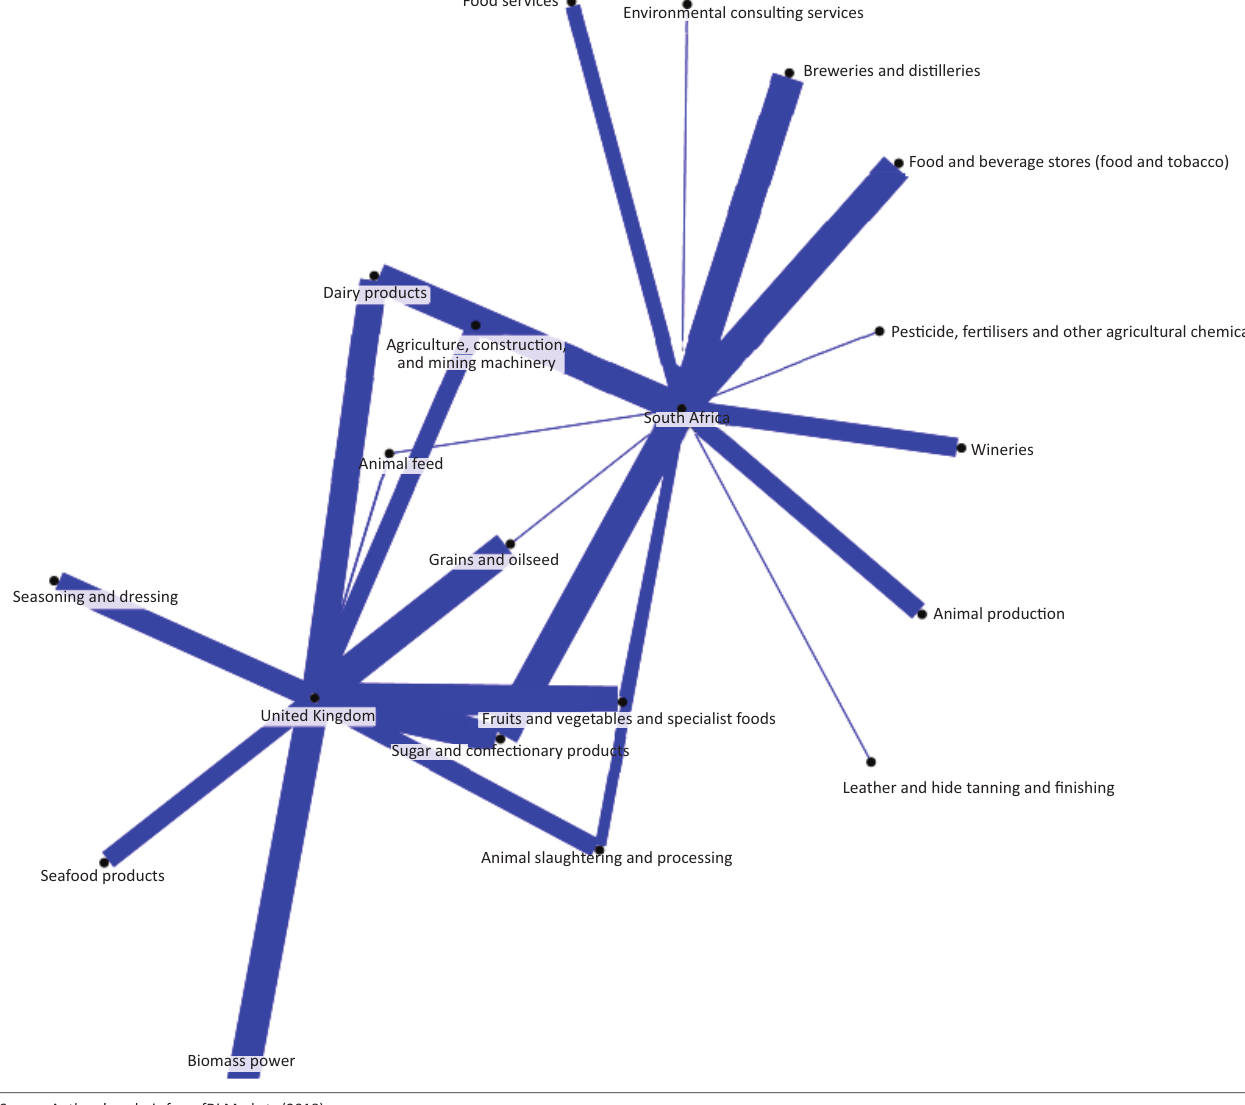
FIGURE 2: Foreign direct investment linkages in agriculture between the United Kingdom and South Africa versus South Africa and